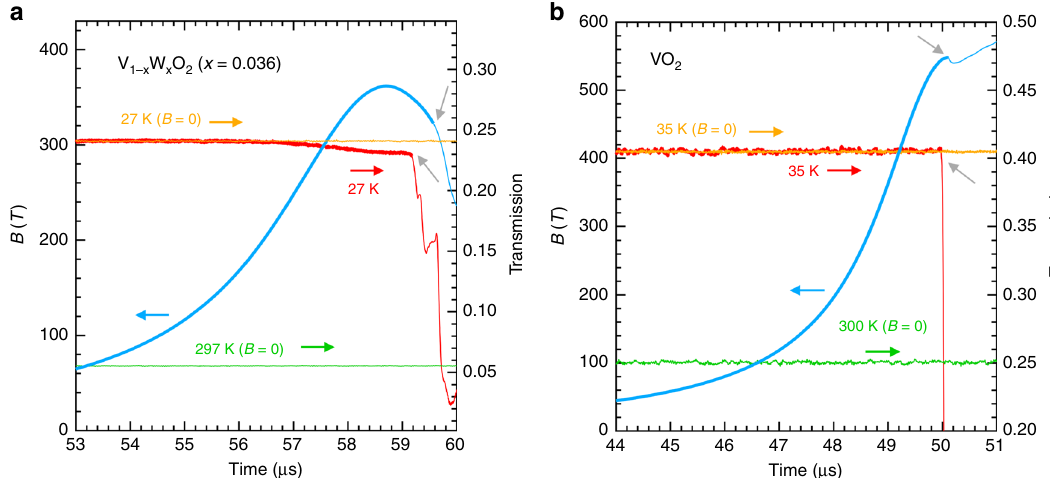
Fig. 5 Temporal evolutions of the magnetic fi eld and optical transmissions in V 1 − x W x O 2 . a Evolutions of the magnetic fi eld (blue curve) and the optical transmission in V 1 − x W x O 2 ( x = 0.036) at 27 K (red curve). The temporal evolutions of the transmission at 27 K and 297 K before applying the magnetic fi eld are also shown with orange and light green curves, respectively. The two grey arrows show the breaking points of the measurements of the magnetic fi eld and optical transmission, respectively. The magnetic fi eld and optical transmission in the fi eld after the breaking points are denoted with thin curves. b Evolutions of the magnetic fi eld (blue curve) and the optical transmission in VO 2 at 35 K (red curve). The temporal evolutions of the transmission at 35 K and 300 K before applying the magnetic fi eld are also shown with orange and light green curves, respectively. The two grey arrows show the breaking points of the measurements of the magnetic fi eld and optical transmission, respectively. The magnetic fi eld and optical transmission in the fi eld after the breaking points are denoted with thin